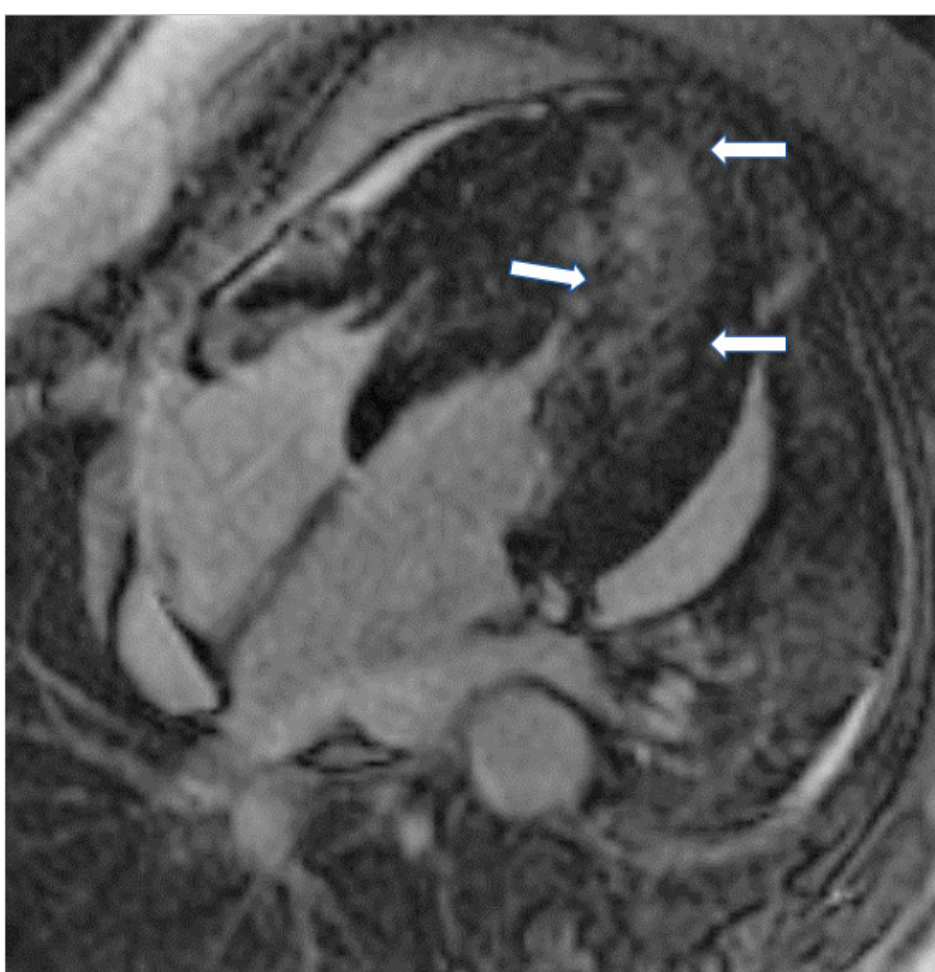
Figure 4. Four chamber inversion recovery image showing severe hypertrophy and extensive LGE (arrows).